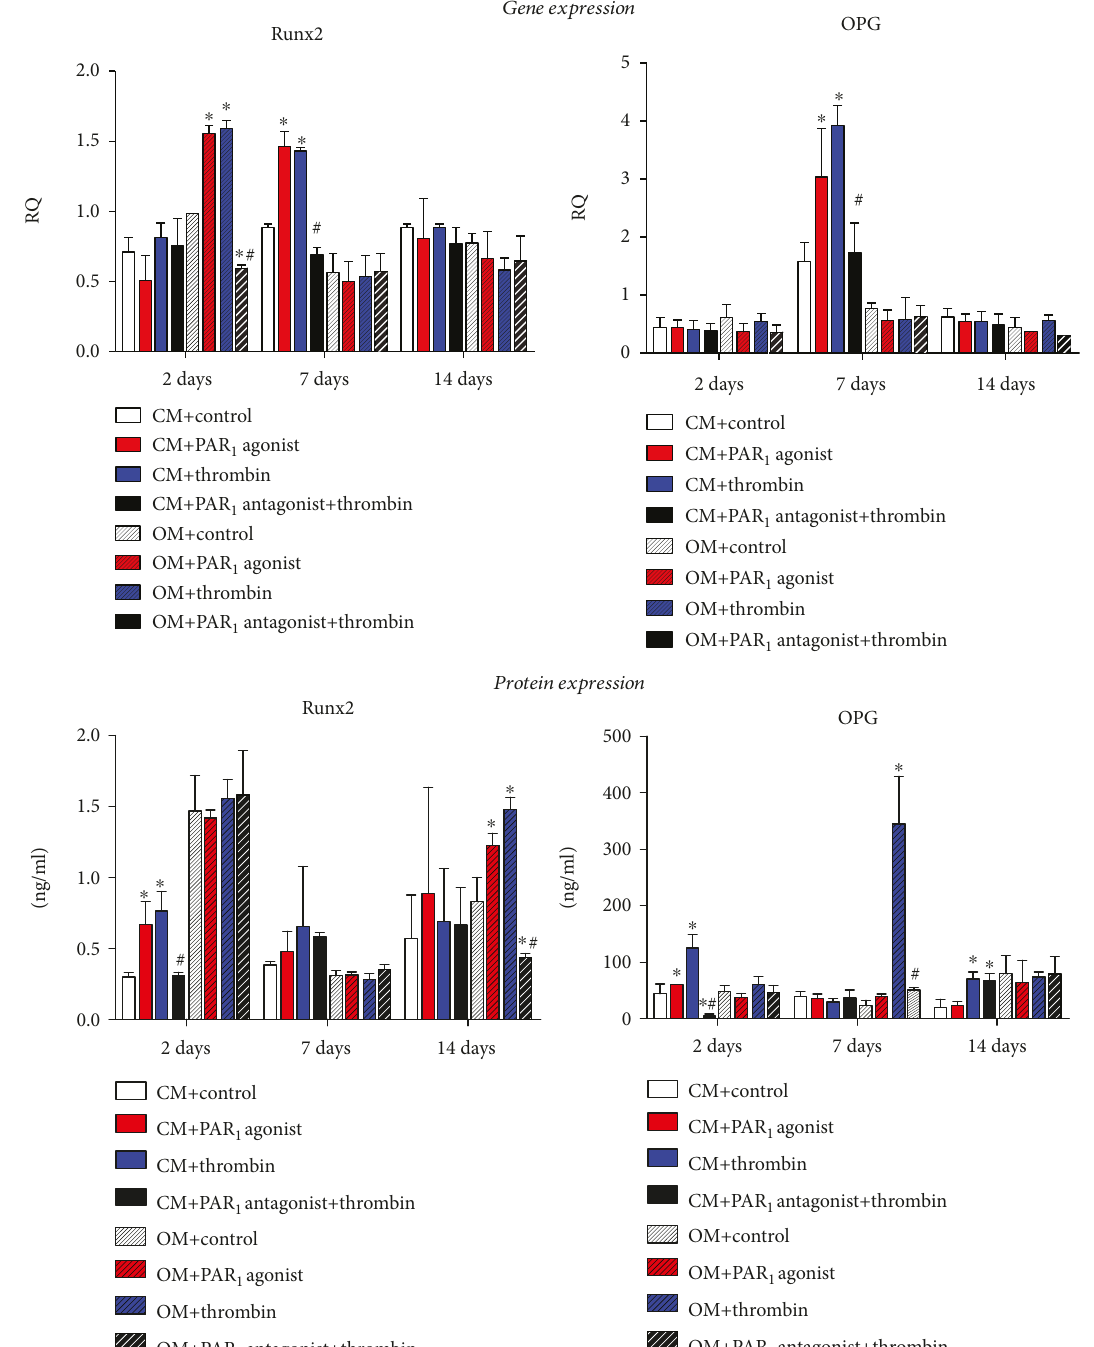
Figure 6: E ff ects of PAR activation on Runx2 and OPG protein and gene expression at 2, 7, and 14 days. Values are presented as mean and 1 SEM; n = 3 . ∗ Mean signi fi cant di ff erence when compared to control of the same medium and time point ( p < 0 05 ). # Mean signi fi cant di ff erence when compared to thrombin treatment of the same medium and time point ( p < 0 05